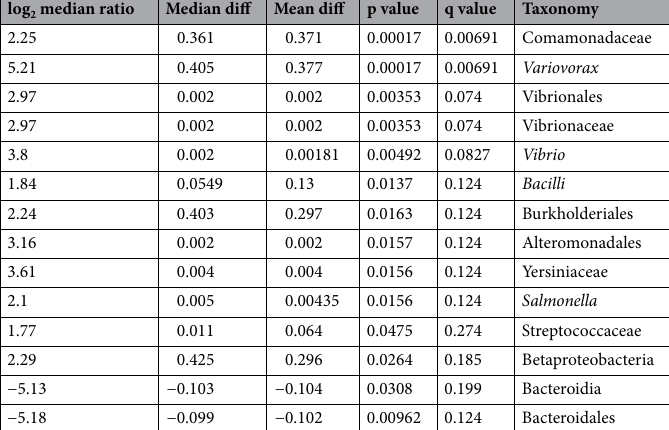
Table 6. Log2 median ratio counts of taxa associated with COVID-19 mortality when comparing deceased (n = 10) versus survived (n = 15). Comparisons were conducted using Wilcoxon rank sum test and adjusted for multiple test comparisons using the Benjamini Hochberg correction method. A full list of significant taxonomic comparison values at the species level can be found in Supplementary Table